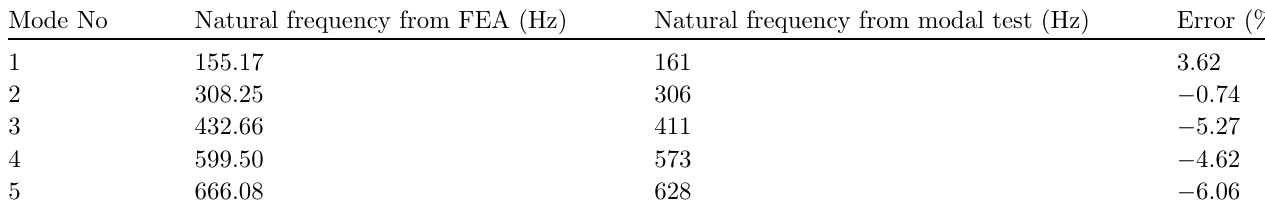
Table 5. Comparison of the natural frequencies obtained through FEA and experiment. Mode No